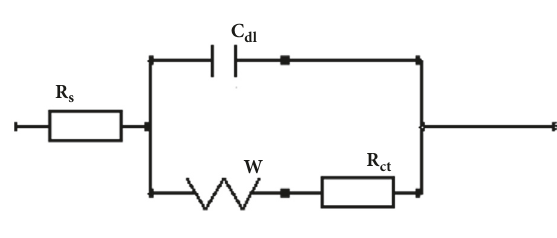
Figure 4: Equivalent circuit fitted for EIS measurements of steel reinforcement in contaminated